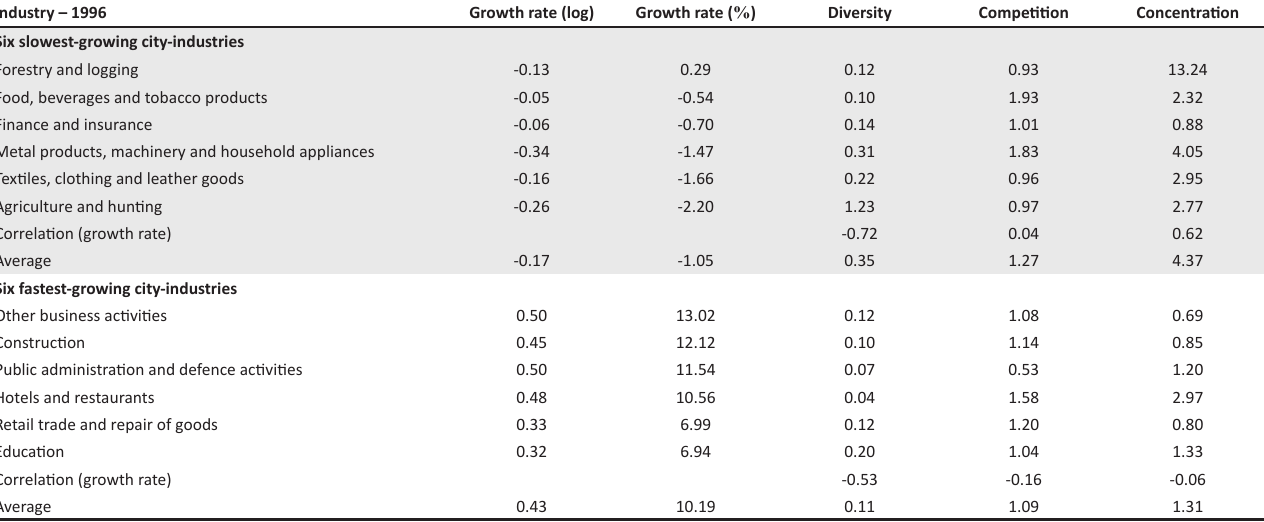
TABLE 4: Description of the data: Panel D (city-industry growth in the 12 cities). Industry – 1996